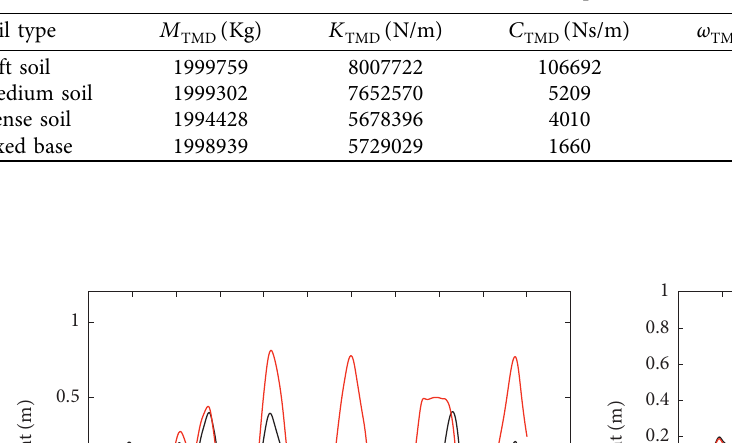
Table 6: EL Centro wave optimization TMD parameters.